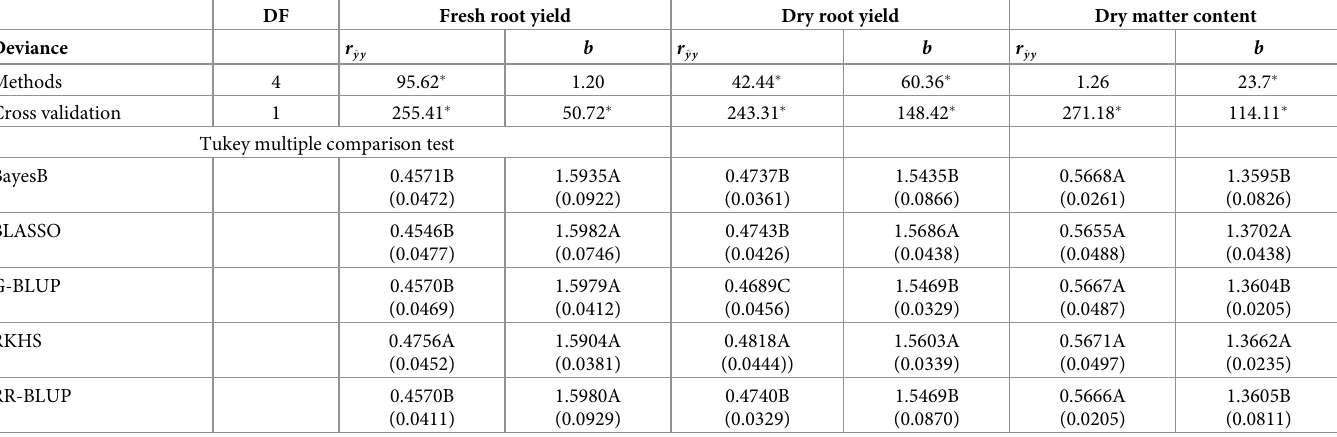
Table 2. LRT analysis and Tukey’s pairwise test (p � 0.05) for genomic selection prediction for the first cross-validation strategy for fresh root yield, dry root yield and dry matter